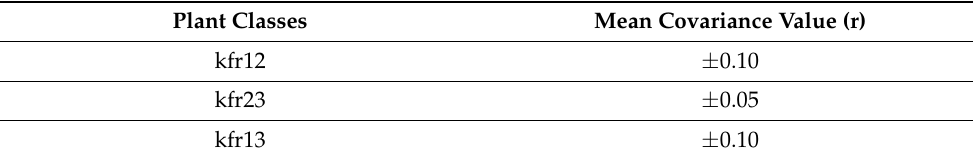
Table 3. Mean covariance values for pairs of plant classes.